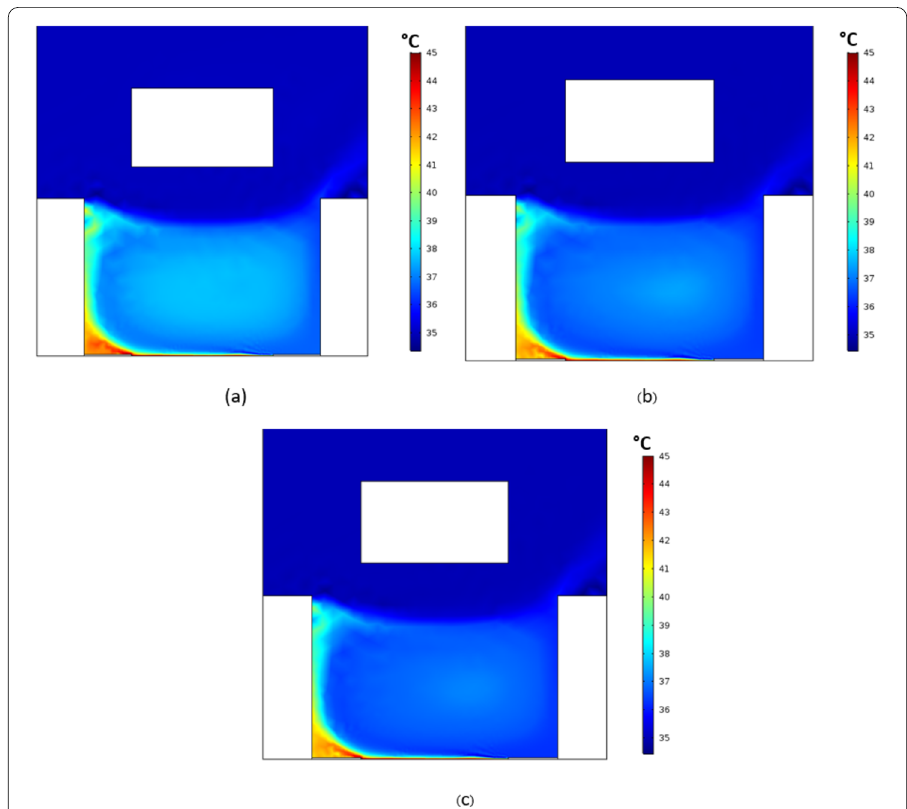
Figure 3 The surface temperature ( ° C) at steady state of the zoom-in selected area: ( a ) u = 7 km/h (gentle wind), ( b ) u = 18 km/h (moderate wind) and ( c ) u = 25 km/h (strong wind)